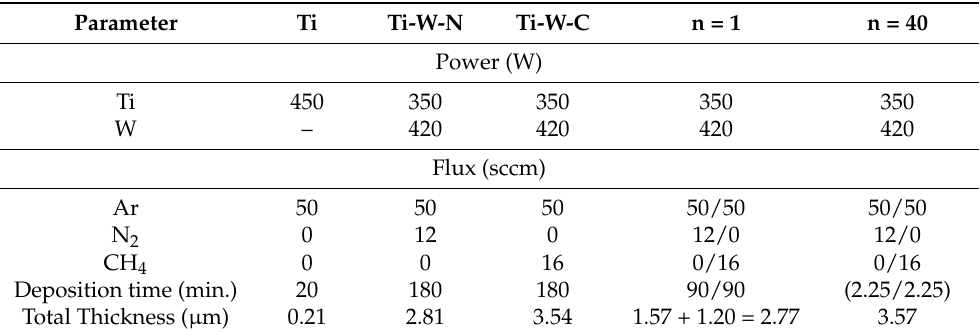
Table 1. Deposition parameters and coating thicknesses for each coating: adhesion layer, monolayers, n = 1 bilayer and n = 40